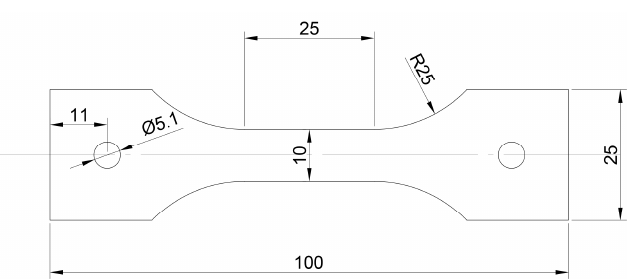
Figure 1. Geometry of the tensile specimen (mm).